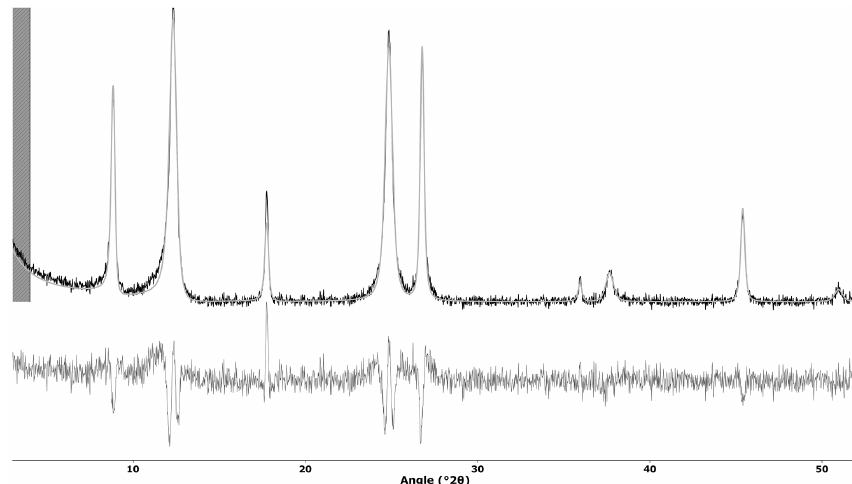
Figure 9. The input (black solid line) and refined (grey solid line) AD pattern and their difference (grey solid line at the bottom) for the multi- specimen set-up of assemblage 4. An observant user should see the mismatches in the patterns and realize his model needs